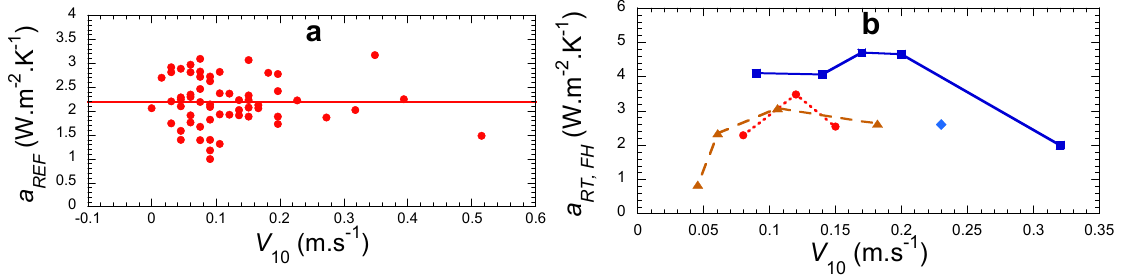
Figure 15. Variation of the heat transfer coefficients with windspeed. ( a ) REF surface. ( b ) VW and AD rooftop and front hood surfaces. VW car: Red circles (RT) and brown triangles (FH). AD car: Blue square (RT) and light blue diamond (FH).